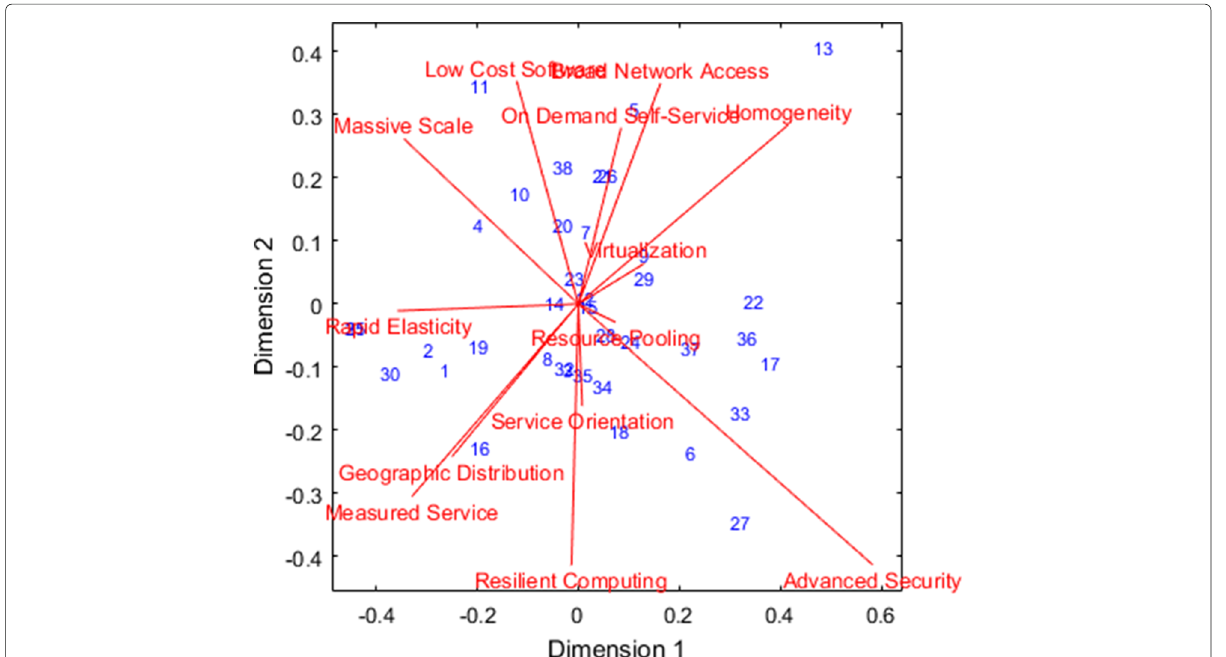
Fig. 1 2-dimensional biplot of the full 13-characteristic dataset. AdvancedSecurity is the dominant variable (i.e. the vector with the greatest magnitude) of the solution driven largely by cases 27, 6 and 33. Diametrically opposed to AdvancedSecurity is MassiveScale and LowCostSoftware , driven largely by case 11. Virtualisation , ResourcePooling and ServiceOrientation contribute little to the solution. Other associations are evident, e.g. orthogonal to these are Measured Service and GeographicDistribution driven by case 16, and opposed to this is Homogeneity driven strongly by case